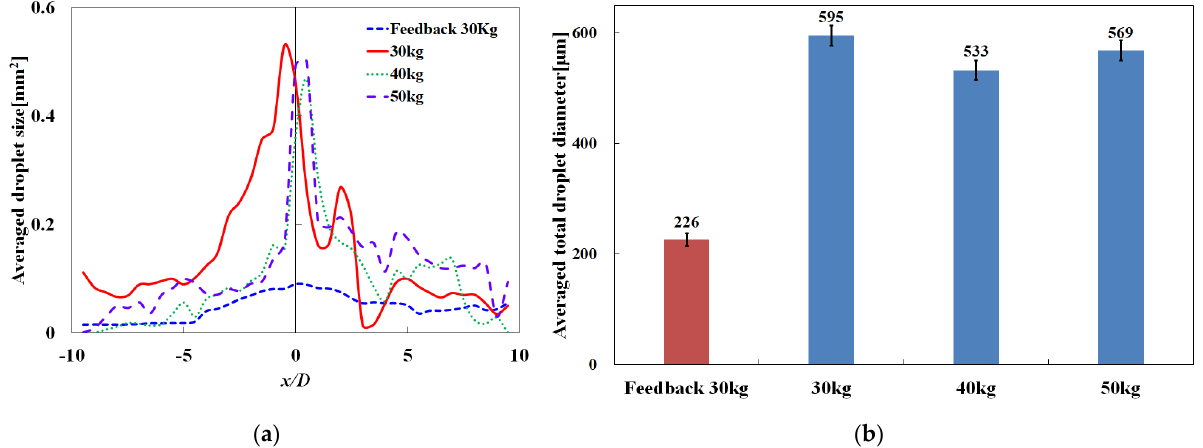
Figure 14. ( a ) Distributions of averaged particle size along a radial direction and ( b ) comparison of total droplet diameter for the non-feedback nozzle.